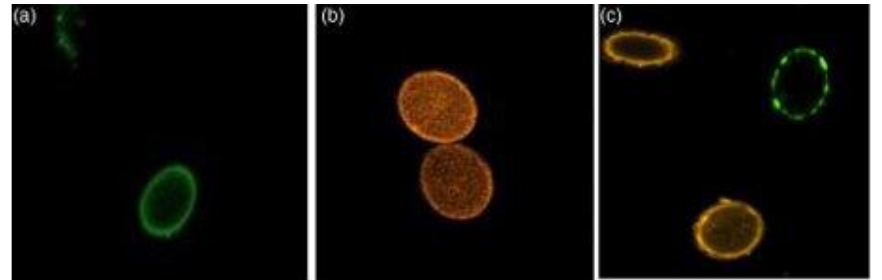
Figure 5. Confocal microscopy images of A. suum ova stained with Syto 9 (green) and propidium iodide (red) to determine the viability of ova: ( a ) viable ova, ( b ) non-viable ova, ( c ) both viable (green) and non-viable (red) ova. (Reproduced from [77]).